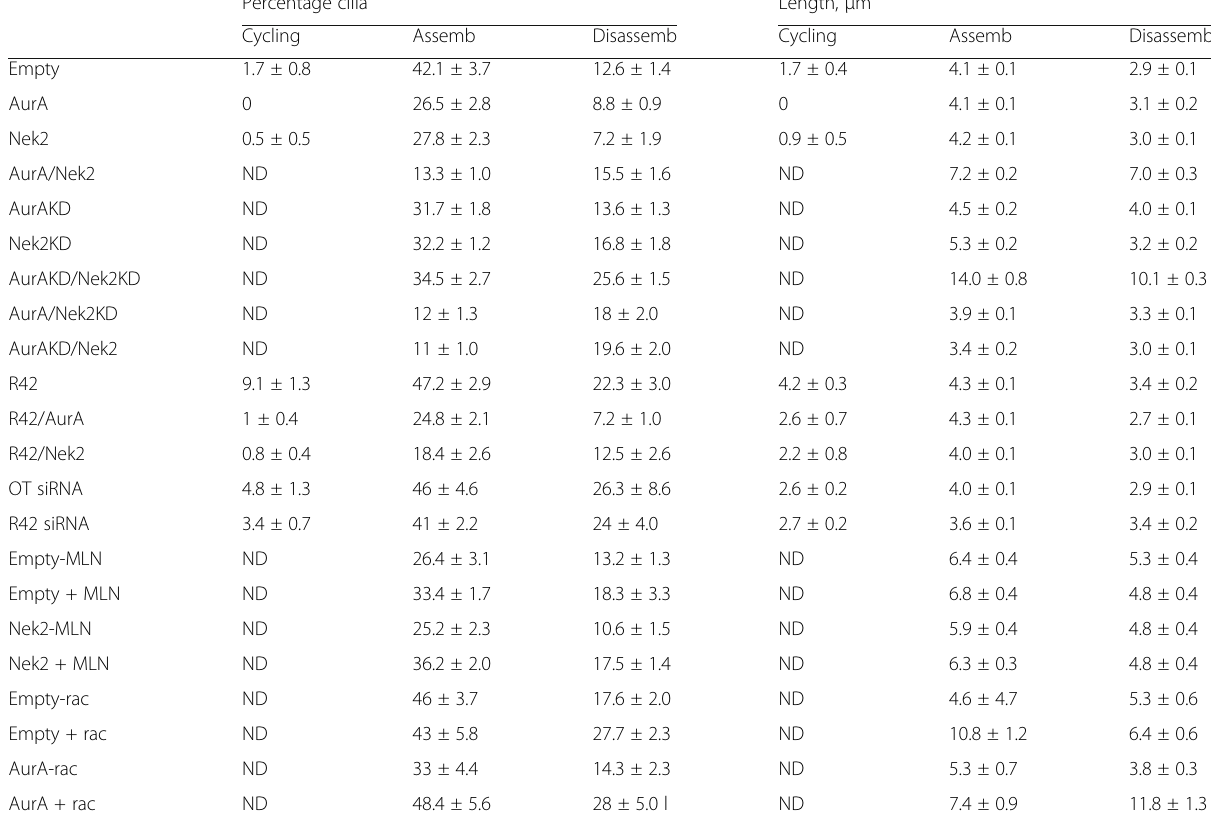
Table 1 Summary of percentage cilia and length for